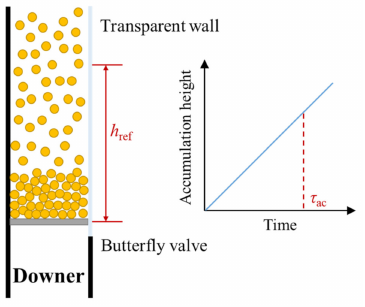
Figure 1. Schematic diagram of accumulation